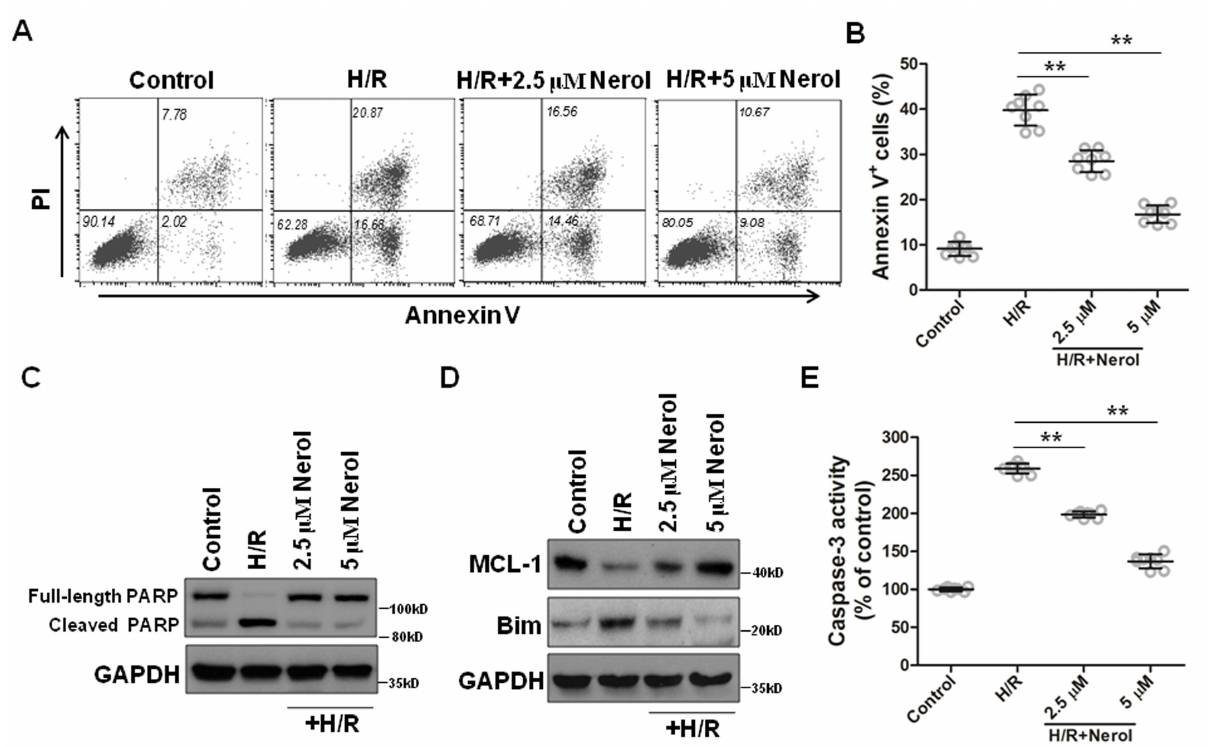
Figure 3. Nerol inhibited H/R-induced apoptosis in cardiomyocytes. (A & B) H9c2 cardiomyocytes were treated with 2.5 μM or 5 μM Nerol, followed by H/R treatment for 12/12 h. And then cells were stained with Annexin V-FITC and PI, followed by cell apoptosis analysis on a flow cytometer (A). Percentages of annexin V+ are indicated (B). (C) H9c2 cardiomyocytes were treated with 2.5 μM or 5 μM Nerol, followed by H/R treatment for 12/12 h. Then, cells were lysed for western blot against PARP, a biomarker of cell apoptosis. (D) The above cells were also lysed for western blot against MCL-1 and Bim. GAPDH was used as a loading control. E. The activity